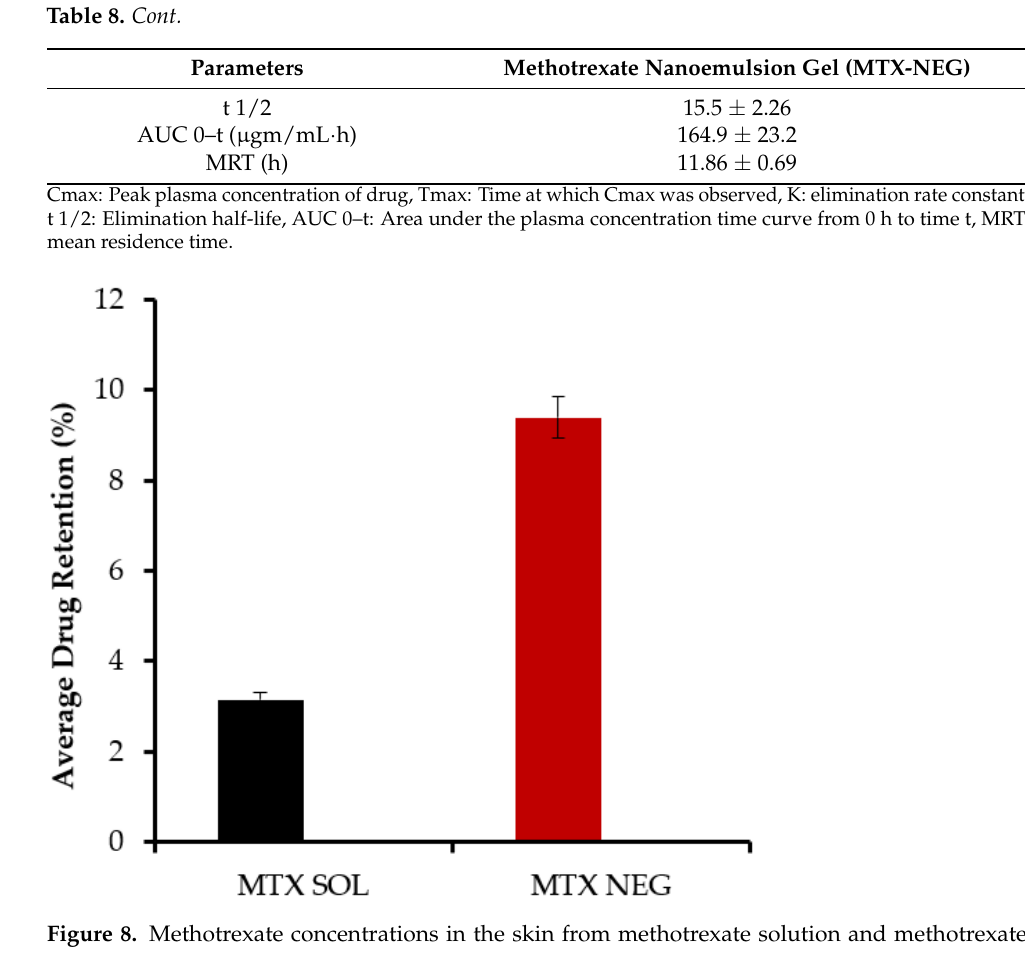
Table 8. Pharmacokinetic parameters of methotrexate from methotrexate nanogel upon administration on skin in rabbits up to 24 h.